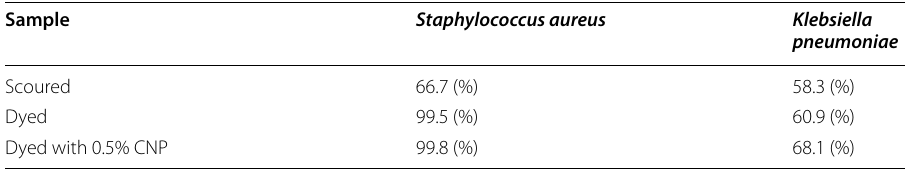
Table 7 Bacteria reduction rate of cotton dyed with Euphorbia with and without cellulose nanoparticles